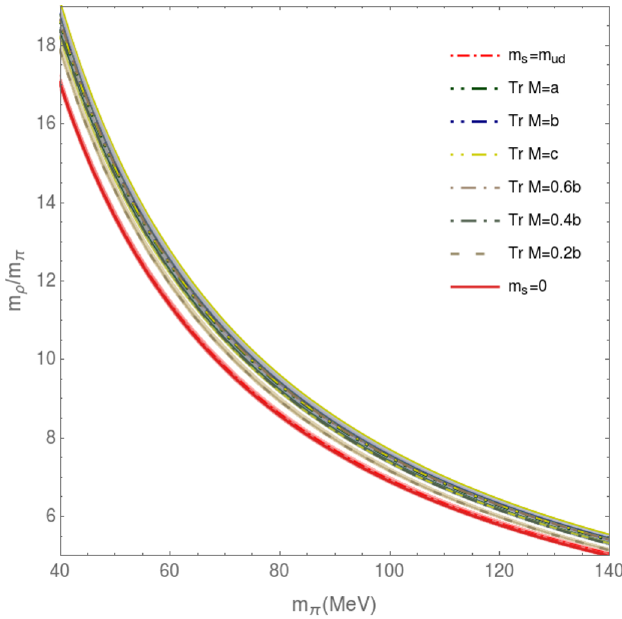
Figure 28 . m (cid:26) =m (cid:25) ratio as a function of m (cid:25) for the Tr M = C , m s = m ud and m s = 0 trajectories continued towards lighter pion masses.